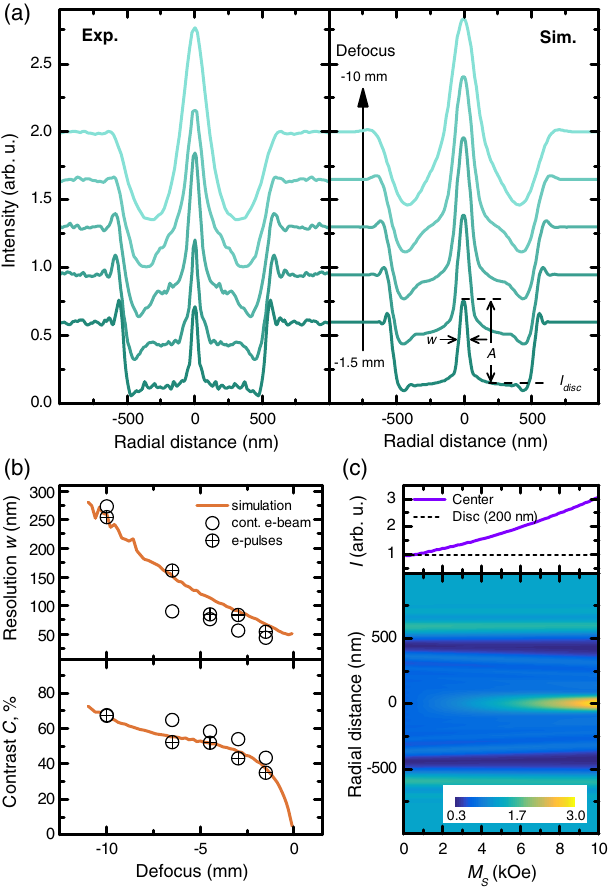
FIG. 3. Spatial resolution and quantitative image analysis in femtosecond Lorentz microscopy. (a) Radial profiles of exper- imental micrographs (left panel) and simulated images (right panel) at defoci of − 10 , − 6 . 5 , − 4 . 5 , − 3 . 0 , and − 1 . 5 mm. Micrographs were obtained using the same illumination con- ditions and electron pulse durations as for the time-resolved experiments. (b) Resolution (upper panel, full width at half maximum w of the central peak) and contrast C [lower panel, C ¼ A= ð 2 I Þ , I at 200 nm from the center] extracted from disc disc the radial profiles for different defocus values. (c) Radial profiles of simulated Lorentz images (lower panel) demonstrate an approximate proportionality between the image intensity at the disc center and saturation magnetization (upper